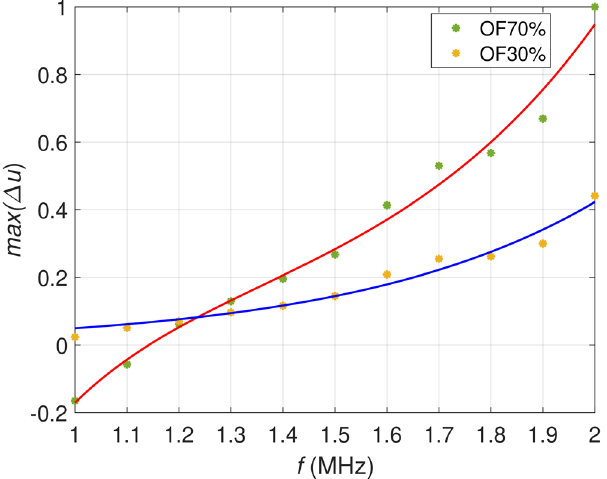
Figure 8. Maximum relative voltages as a function of the excitation frequency. The red line approximates data for OF70%, while the blue line approximates data for OF30%.